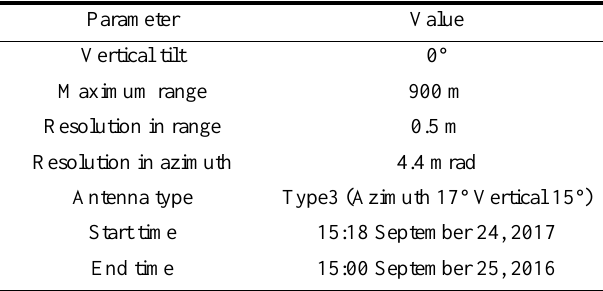
Table 1 listed the main configuration parameters of the measurement campaign.